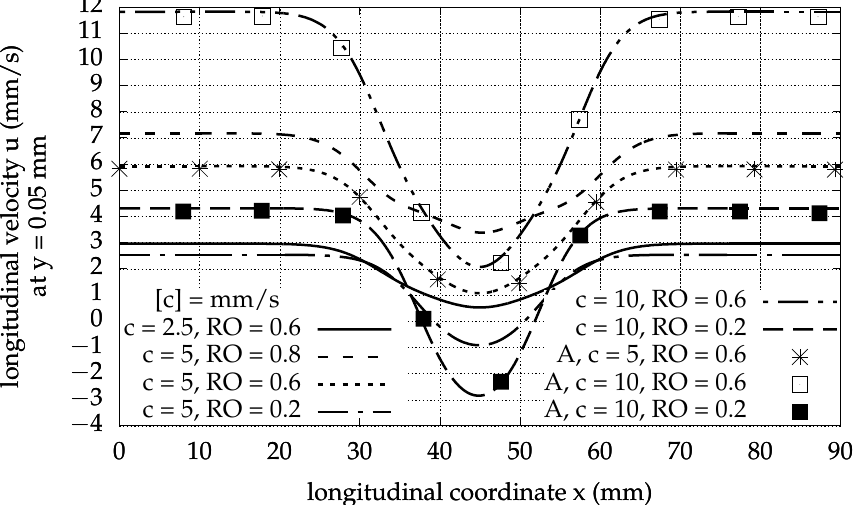
Figure 2. Longitudinal velocity near the central axis of the pump ( y = 0.05 mm) for various values of RO and c , n = 1 and one roller. Comparison with existing results (A: Data from [12]) is presented.